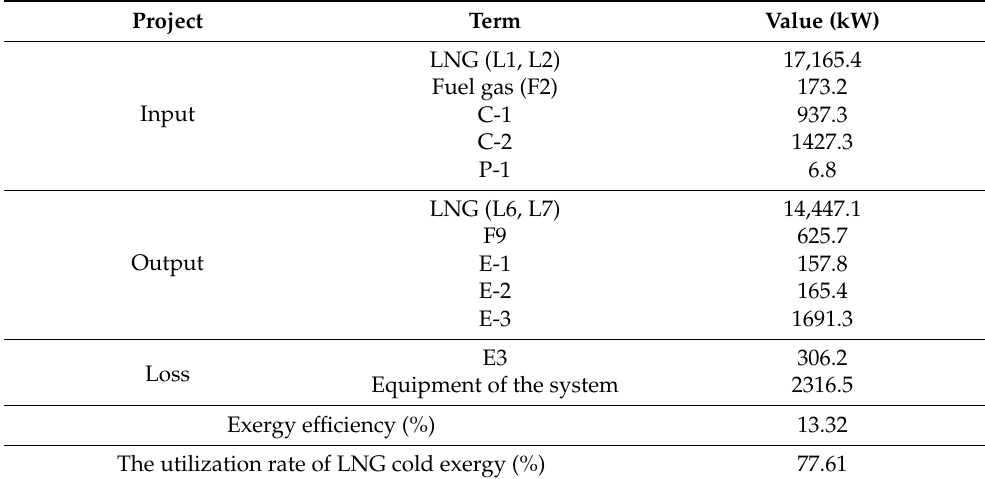
Table 7. The calculation results of exergy input, output, and loss in System